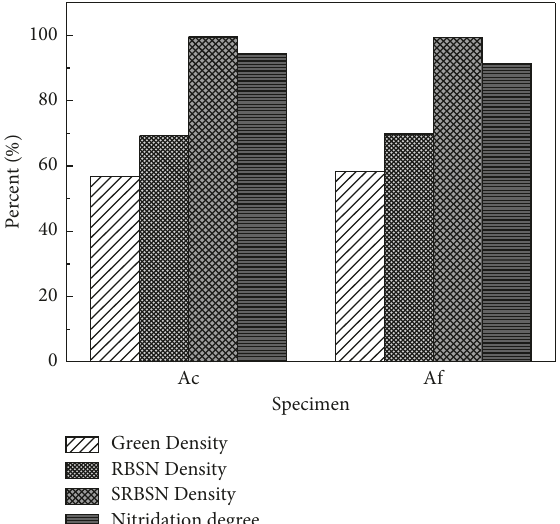
Figure 1: Measurement of densities and nitridation degree for the SRBSN fabricated by the postsintering of